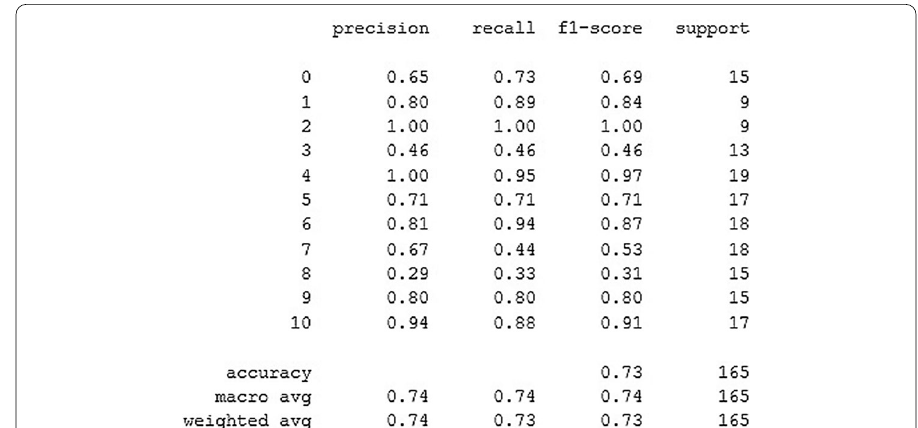
Fig. 3 The classification report based on “Sastrawi”